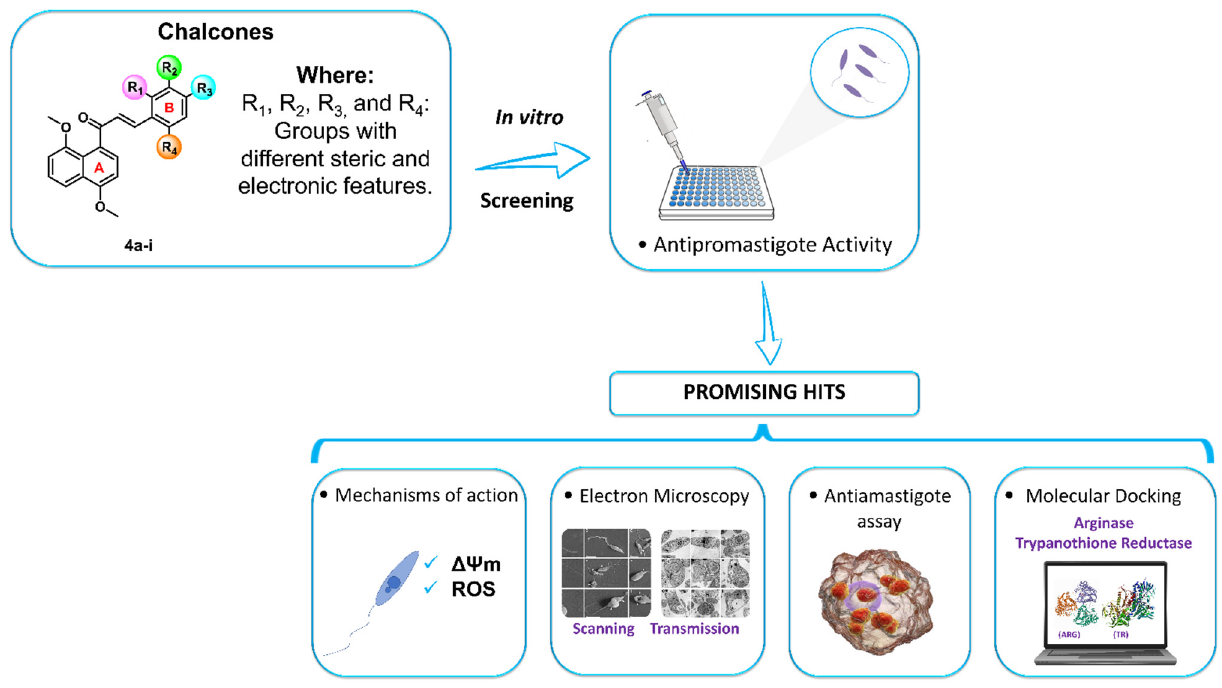
Figure 2. The experimental design approach to the evaluation of the antileishmanial potential of 4,8-dimethoxynaphthalenyl chalcone derivatives ( 4a – i ). 4,8-dimethoxynaphthalenyl chalcone derivatives ( 4a – i